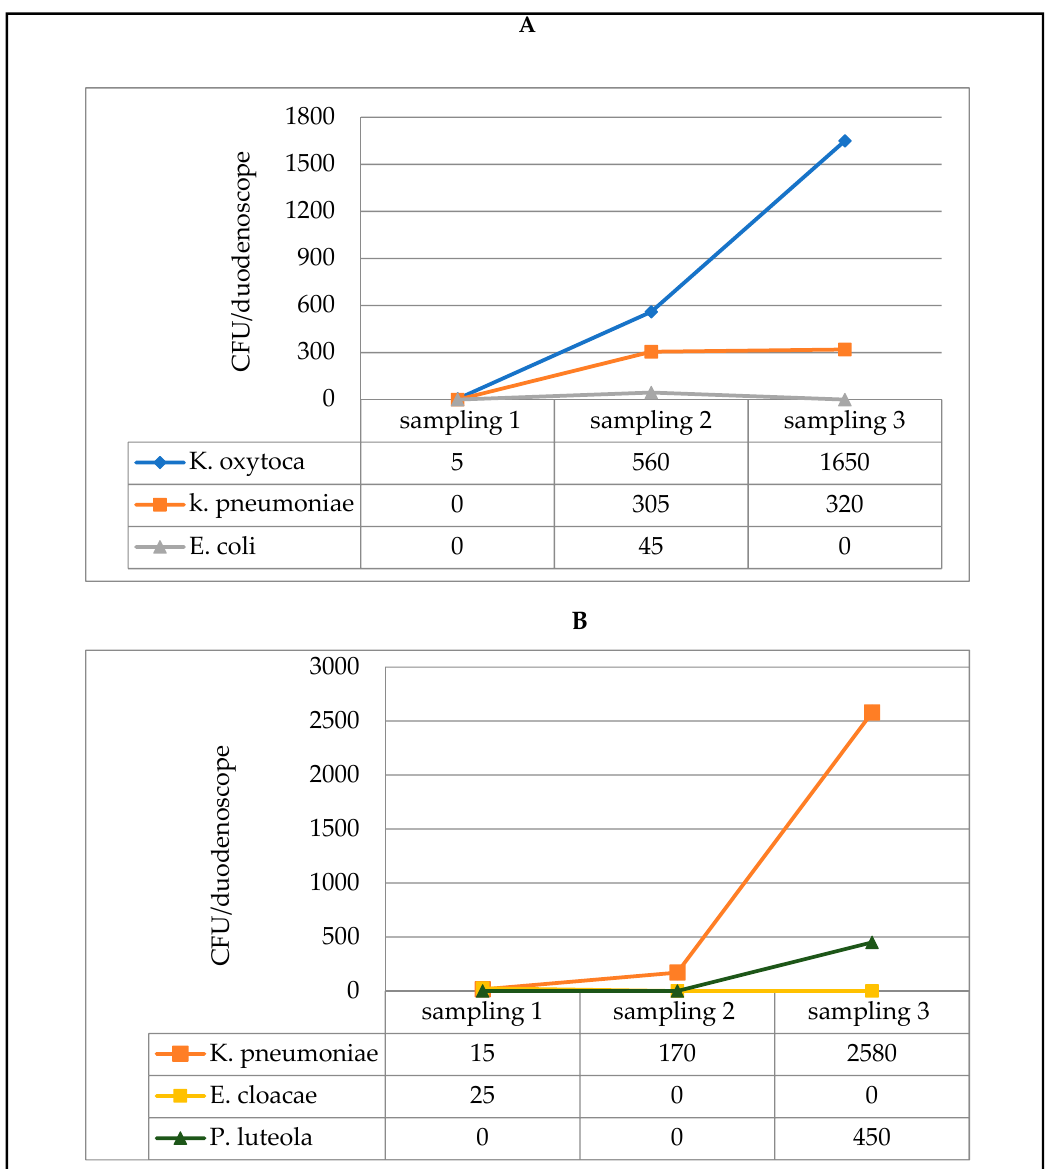
Figure 1. Microbial load measured in three samples, each of which was taken after a reprocessing procedure (3 consecutive procedures on the same day), from one of the three contaminated duodenoscopes: distal end sampling ( A ) and instrument channel sampling ( B ).